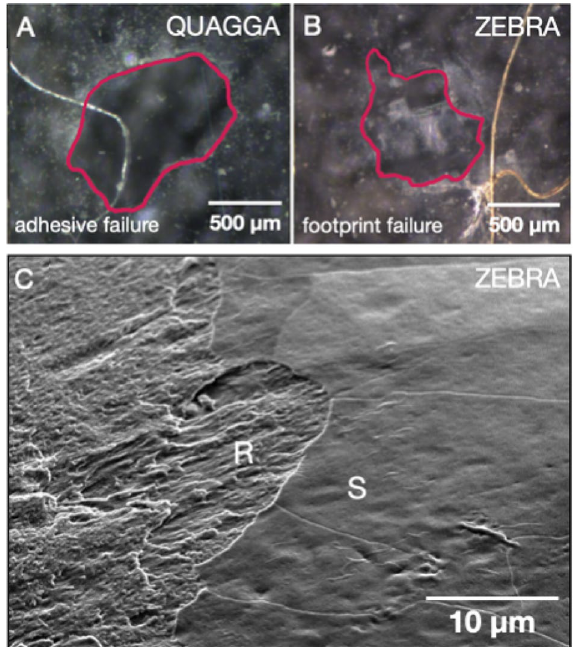
Figure 3. PVC substrates after the detachment of a ( A ) quagga mussel plaque (adhesive failure; complete detachment) and a ( B ) zebra mussel plaque (footprint failure; incomplete detachment); areas marked by the red lines indicate plaque detachment sites. ( C ) SEM micrograph of a detached zebra mussel plaque underside. A footprint failure region in which part of the plaque underside was left behind on the substrate exposing the fibrous plaque interior (denoted by R: rough, fibrous side) and an adhesive failure region in which the smooth plaque underside is intact (denoted by S: smooth side) are clearly